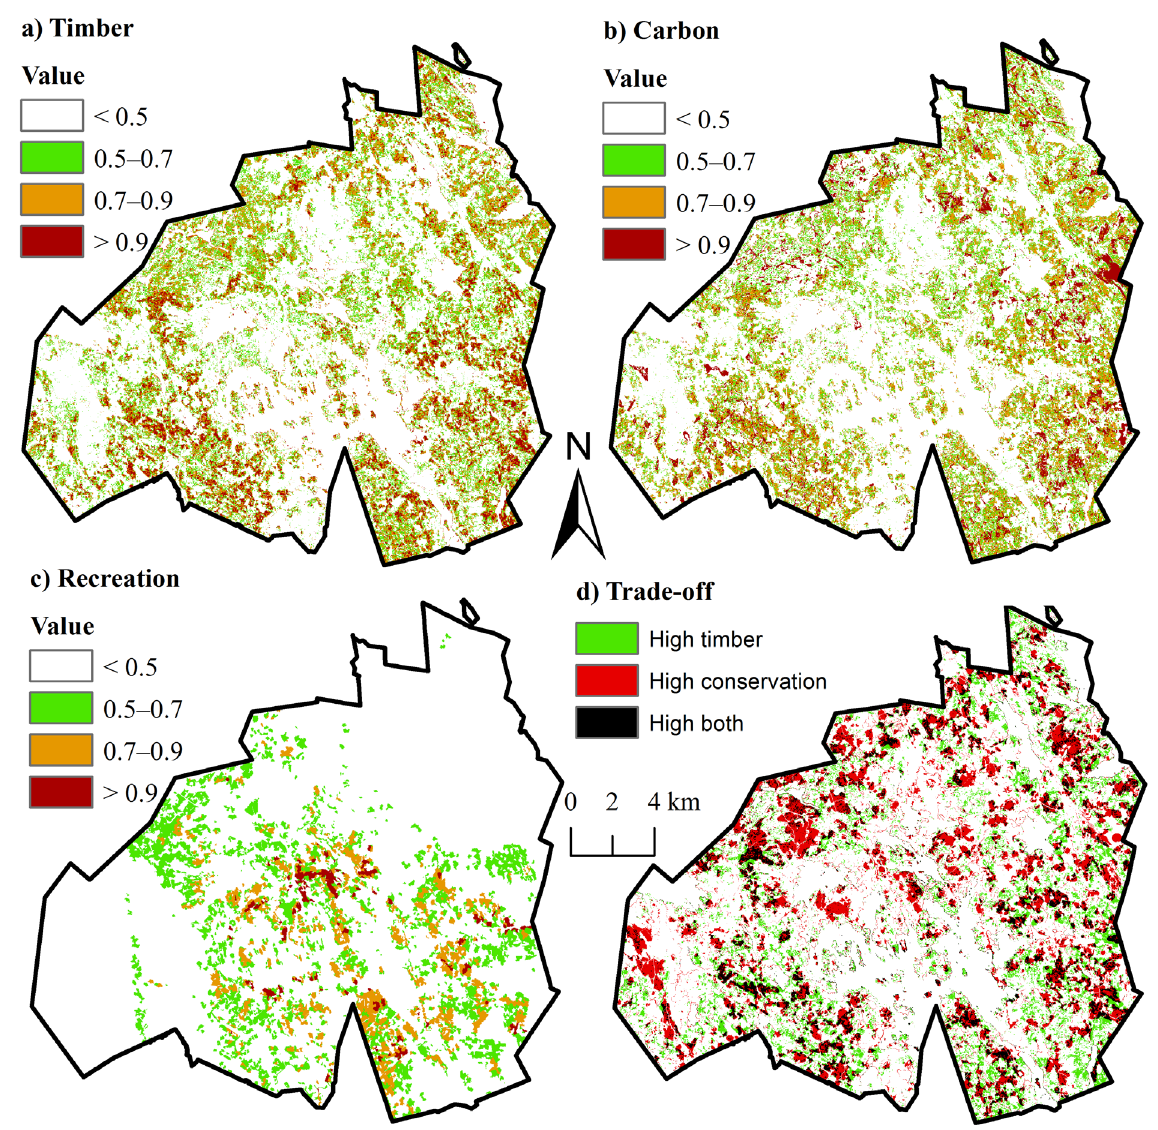
Figure 4: Different ecosystem service maps of the study area a–c and a trade-off image d. In a–c proportional landscape value is drawn with most valuable decile in red. In a and b only forest and peatland areas are considered. In c, classification alternative 1 is used. In d, the areas that belong to most valuable quartile of timber and/or conservation value are drawn using different colors. Only areas in forest and peatland are drawn; hence, there are also areas in highest quartile of conservation value that are not drawn. Conservation value is mapped using Zonation with connectivity only, classification alternative 2, and valuation alternative 6 with no value given to human habitats (Figure 3e). This conservation value map had the highest correlation with the timber map